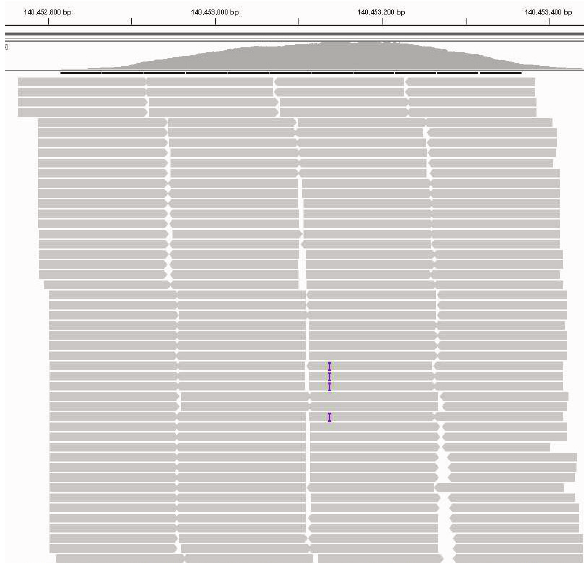
Figure 2: Next-gene sequencing data demonstrating a somatic genomic mutation in BRAF